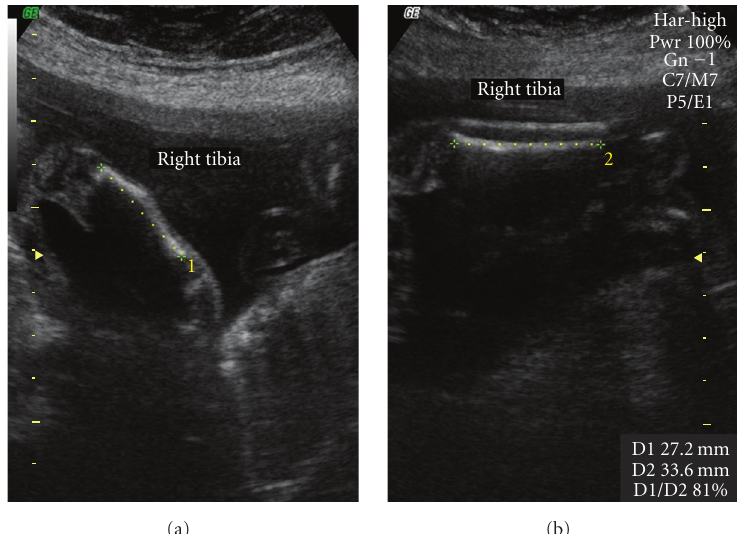
Figure 1: Ultrasound images showing absence of right fibula, bowing of right tibia (a), and tibial discrepancy (right tibia: 27.2 mm and left tibia: 33.6 mm) at 23 weeks gestation (b).